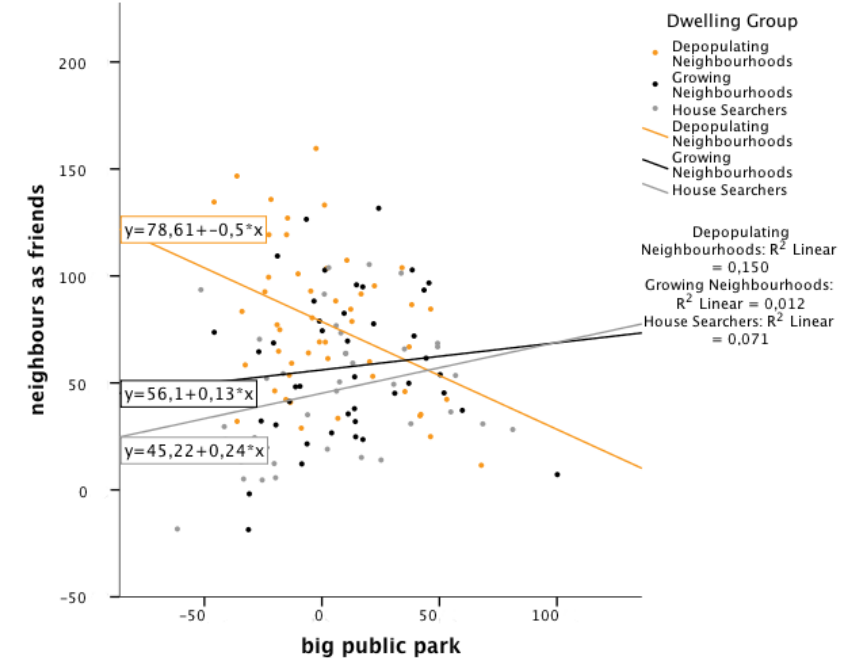
Figure 2. Correlations between the levels “big public park” and “neighbours as friends”, according to the subgroups: “depopulating neighbourhoods”, “growing neighbourhoods”, and “house searchers” (Pearson test) showing the R 2 levels.